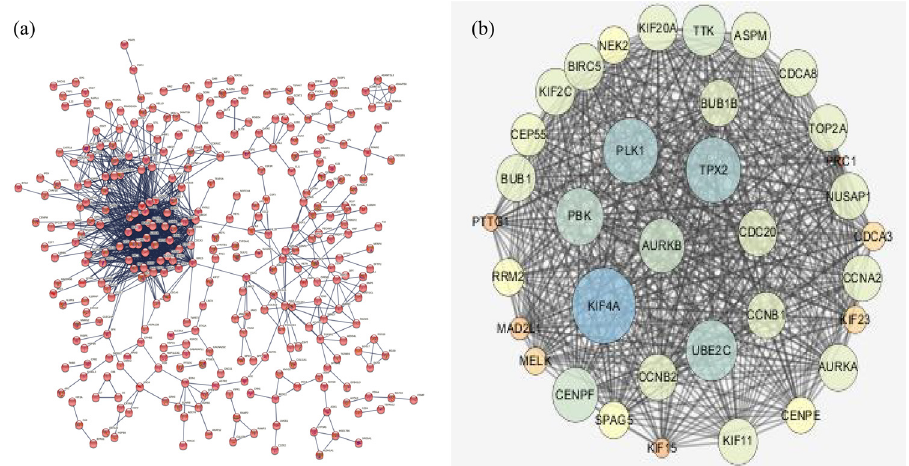
Figure 2: ( a ) PPI network involve 369 nodes and 1617 edges analysis by Cytoscape software. ( b ) Module1 included 35 nodes and 543 edges was regard as the key genes in the PPI network ( MCODE score = 23.79 ) .